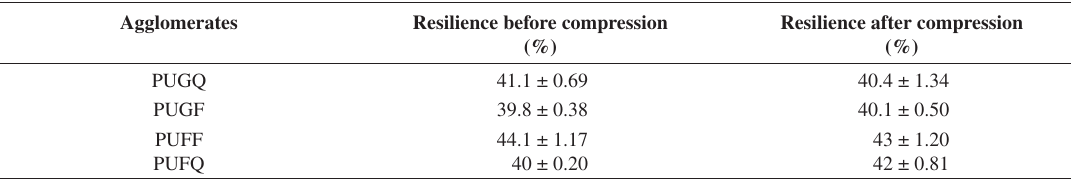
Table 4. Resilience test of PUs agglomerates.